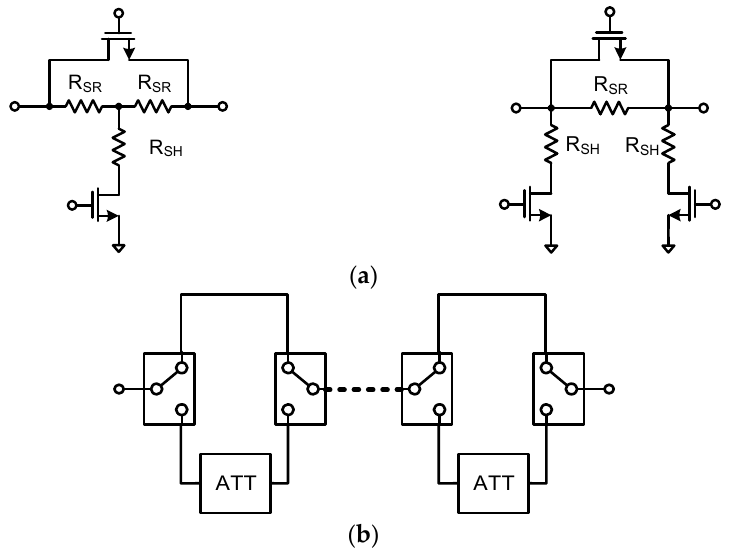
Figure 1. Various attenuator topologies: ( a ) switch embedded T/ π -type, and ( b ) switched path type. In this paper, an S/C/X 4-bit wideband passive digital step attenuator MMIC using 0.25 μ m GaN HEMT technology is presented for its low insertion loss and RMS phase and amplitude errors from DC to 12 GHz.